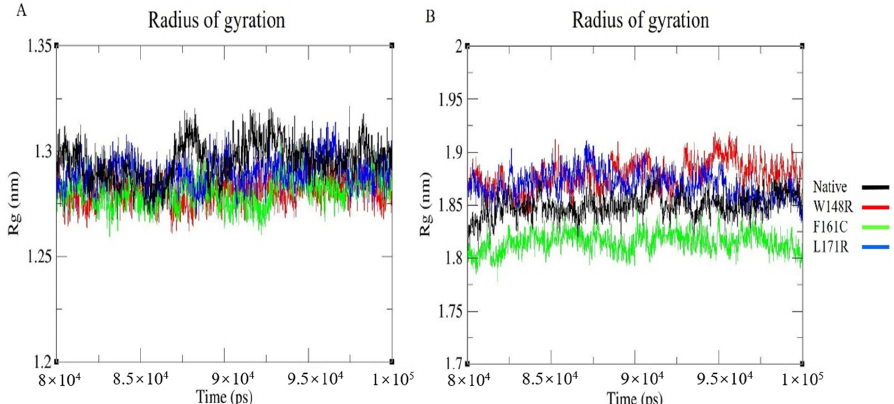
Figure 5. Radius of gyration (Rg) graph representing MDS for last 20 ns of native and mutant ( A ) CH2 domain (residues from 139–242) and ( B ) whole proteins, with X-axis representing time (ps) and Y-axis was representing Rg (nm). Color scheme: Native (Black), W148R (Red), F161C (Green), L171R (Blue).